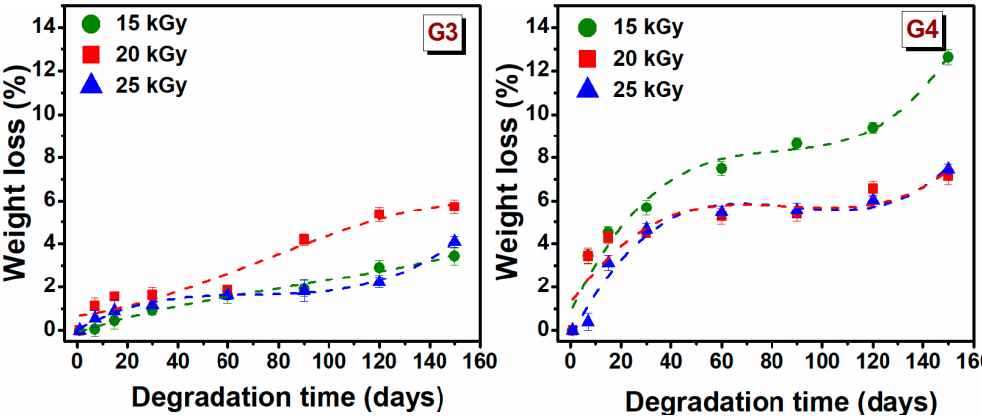
Figure 3. Gradual weight loss (%) of G3 and G4 hydrogels in PBS at 37 ◦